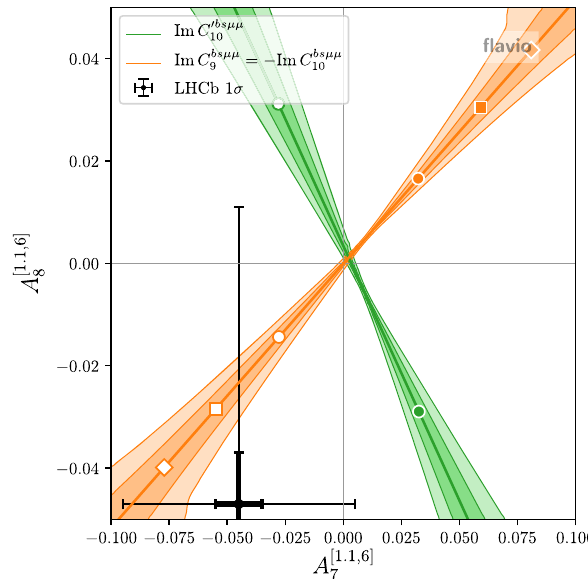
Fig. 3 Theory predictions for A 7 and A 8 in the presence of imaginary Wilson coefficients. The colored bands correspond to the 1 σ and 2 σ theory uncertainties. Circle, square, and diamond markers correspond to Wilson coefficient magnitudes of 0.5, 1.0, and 1.5. Colored markers correspond to positive, white markers to negative values. Also shown are the current experimental results (thin error bars) and a experimental precision goal of 1% (bold error